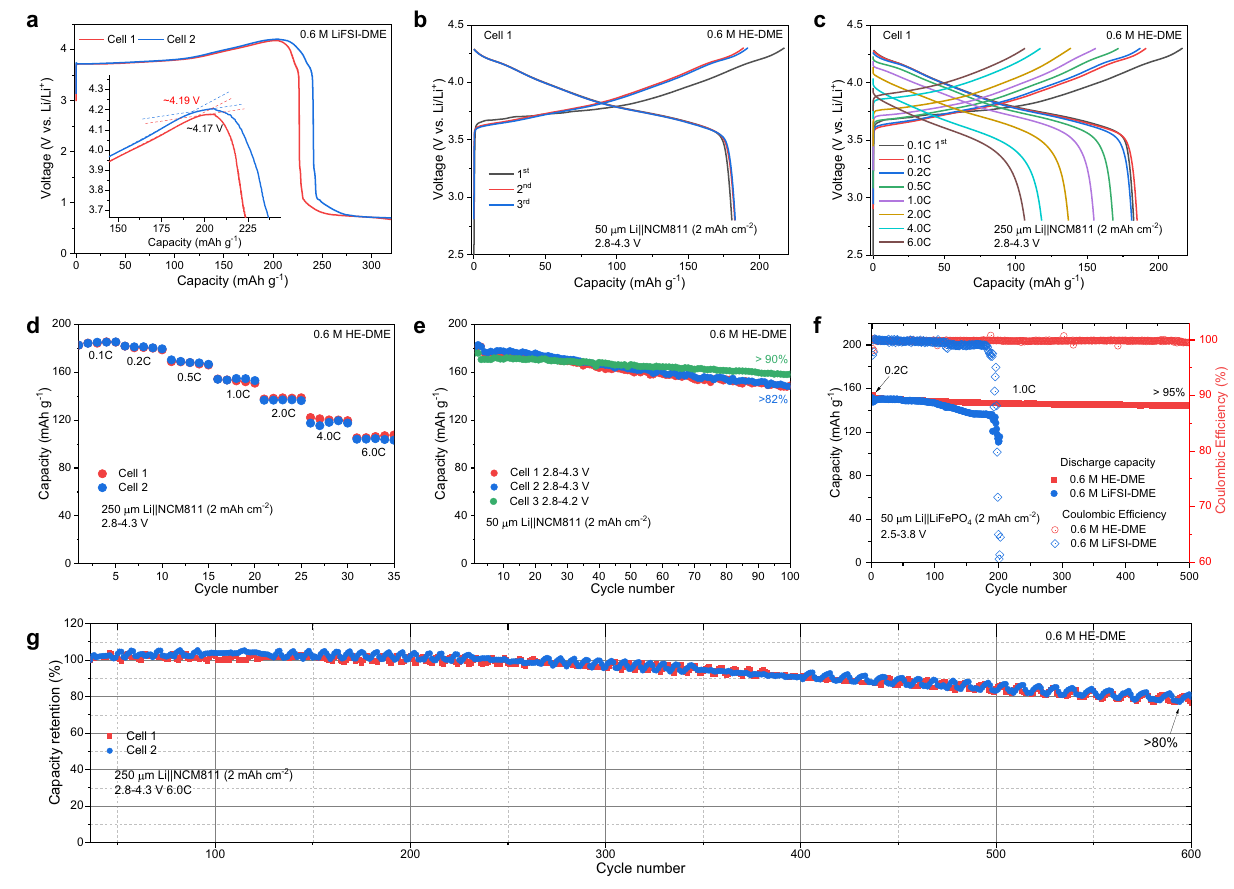
Fig. 2 | Electrochemicalperformance.a , b Galvanostaticcharge/dischargecurves of LiNi 0.8 Co 0.1 Mn 0.1 O 2 (NCM811) cells in a 0.6M LiFSI-DME, b 0.6M HE-DME elec- trolytes within the voltage range of 2.8 – 4.3V at a rate of 0.1C (1C=180mAg − 1 ). Cells were tested with a capacity of 2mAhcm − 2 for NCM811 and 50 μ m lithium metalfoils,resultinginanegative/positivecapacityratio(N/P)of5. c Galvanostatic charge/discharge curves of NCM811 cells in the 0.6M HE-DME electrolyte at